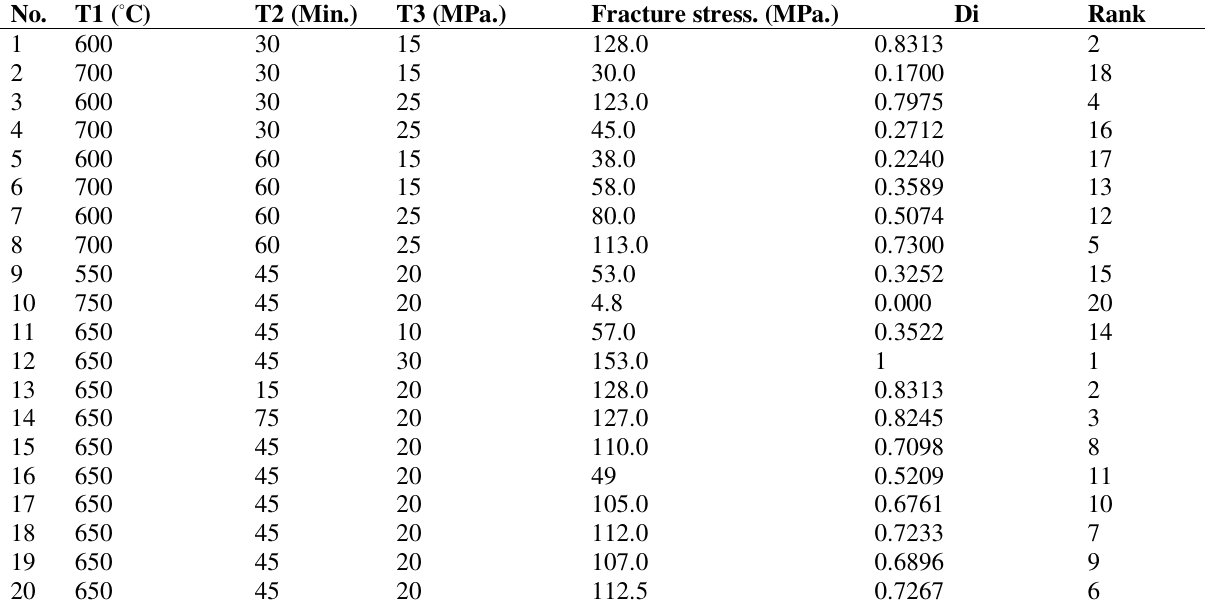
Table Ranks of response surface of results.